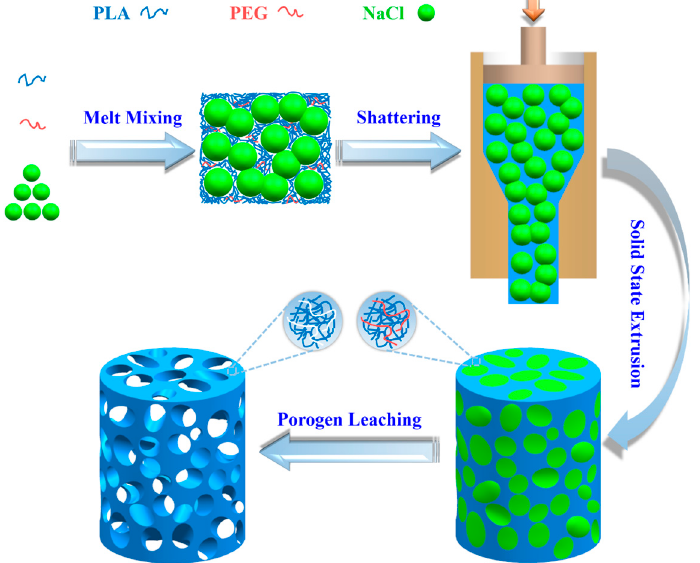
Figure 1. Schematic of fabricating porous PLA scaffolds. The size of NaCl ranges from 25 to 74 μ m, and the diameter of as-prepared porous scaffolds is 10